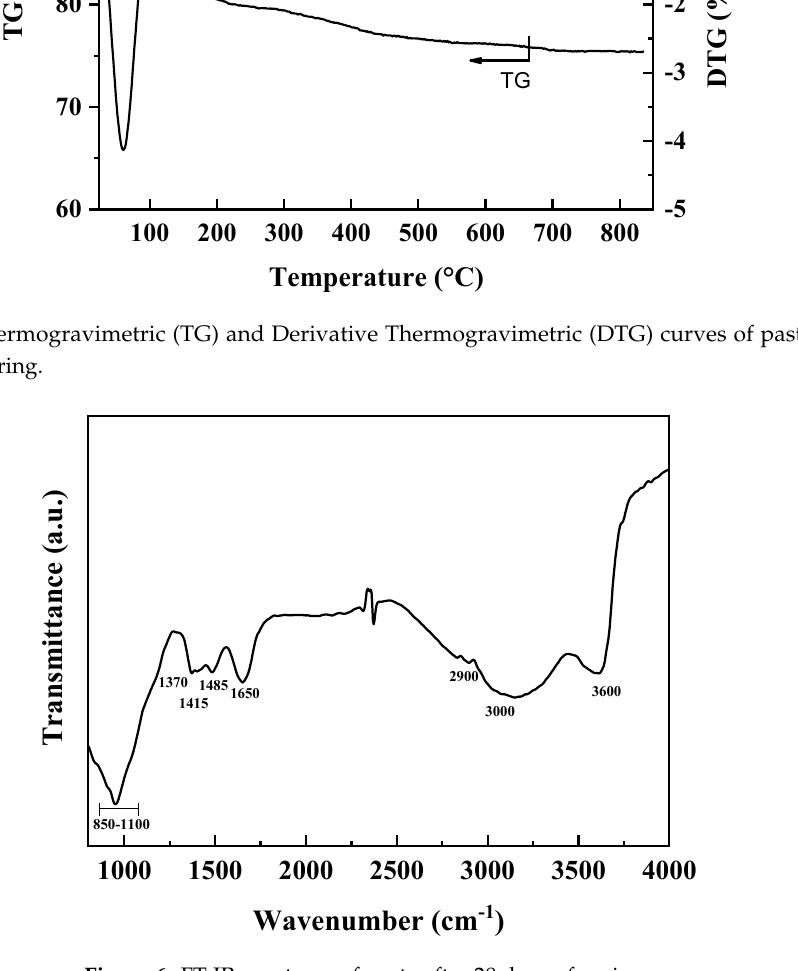
Figure 6. FT-IR spectrum of paste after 28 days of curing.